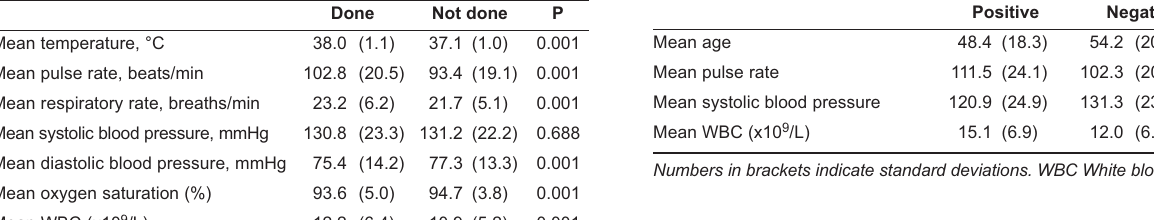
TABLE 2 Comparison of selected physical findings and laboratory data for patients who did and did not have blood cultures performed